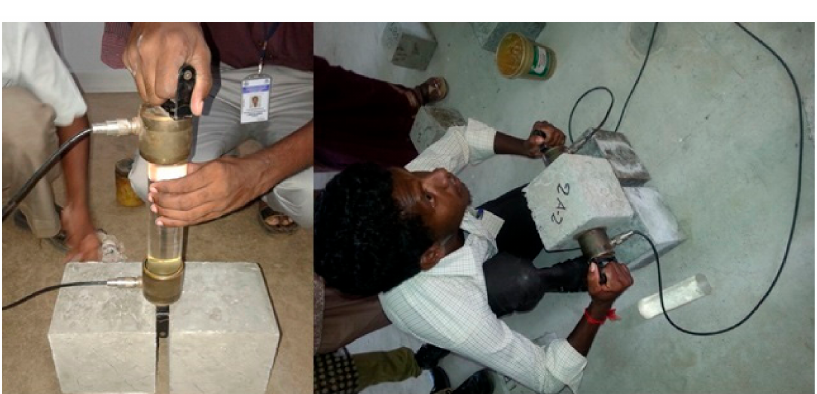
Figure 5. Test set up for ultrasonic pulse velocity test.